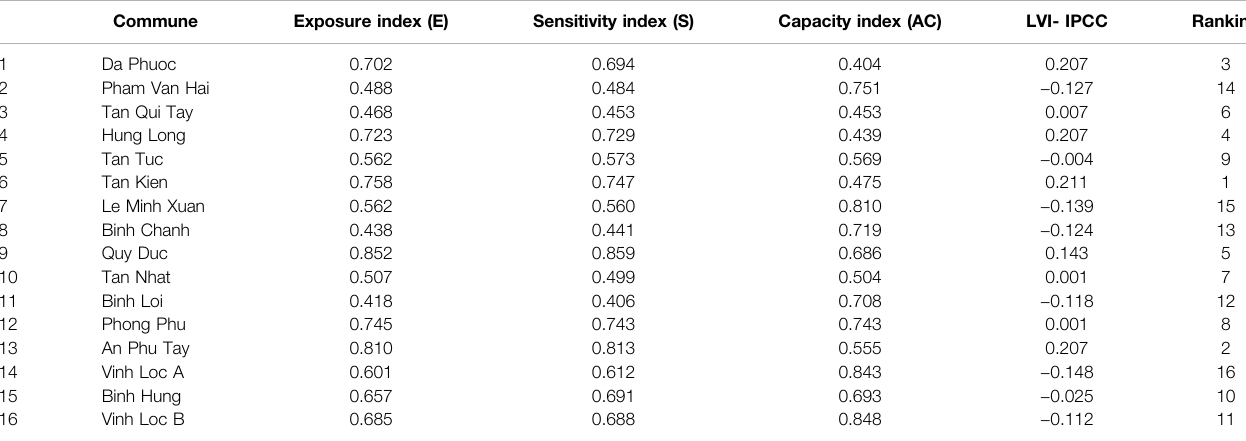
TABLE 3 | LVI-IPCC for communes in the Binh Chanh district. Commune Exposure index (E) Sensitivity index (S) Capacity index